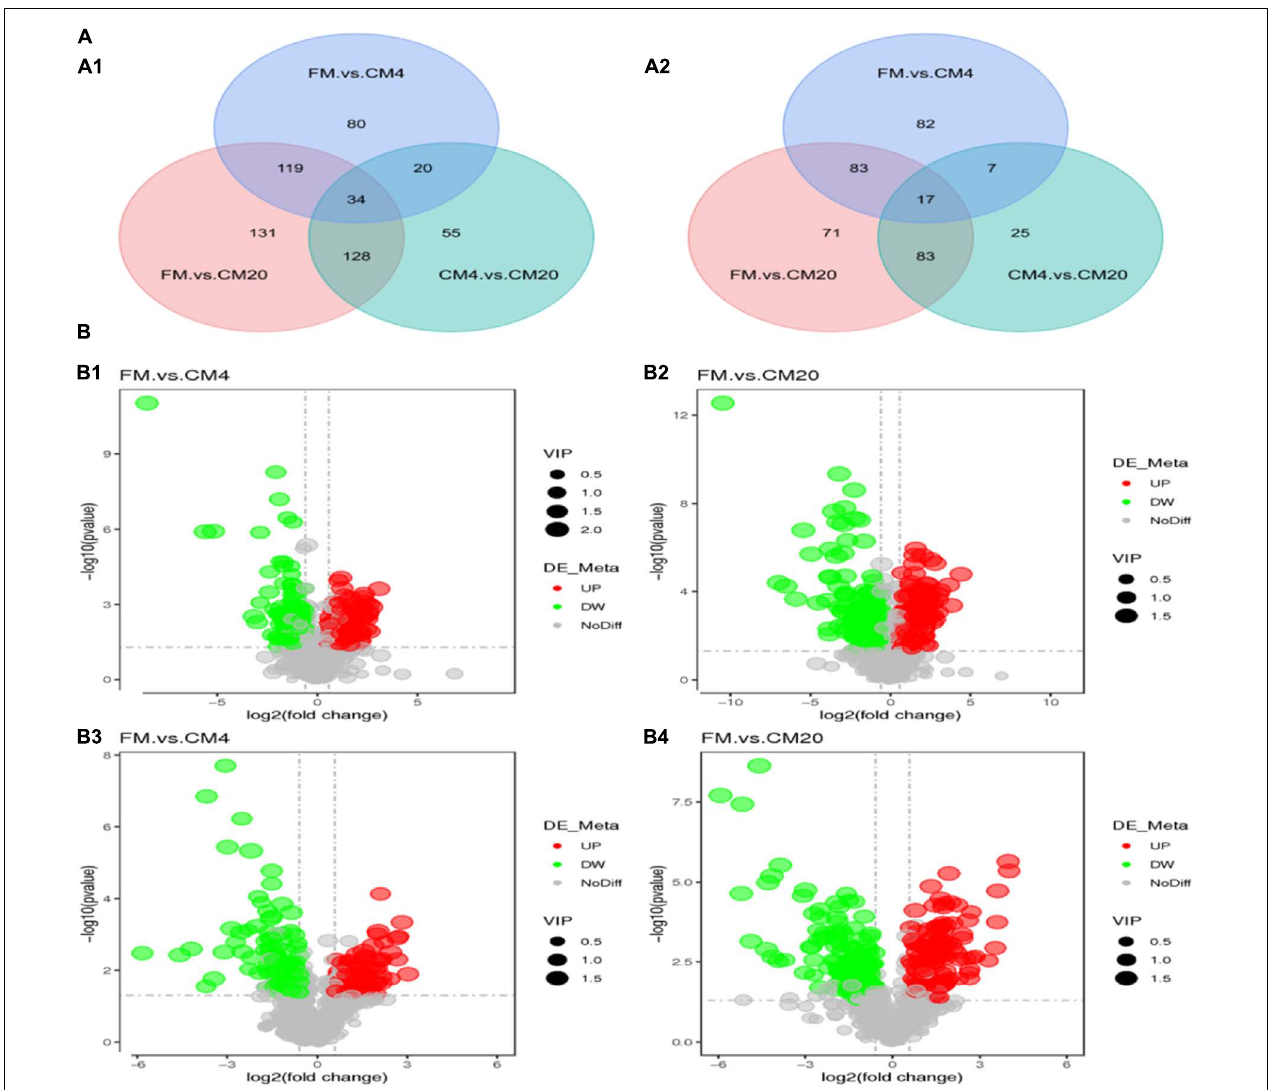
FIGURE 7 | (A) The Venn plot displays the differential metabolites of distal intestinal contents of hybrid grouper between experimental groups in positive (A1) and negative (A2) modes. (B) Volcano plots of p -values between the FM, CM4, and CM20 groups in the positive (B1,B2) and negative (B3,B4) modes. The horizontal coordinate represents the change of expression of multiple metabolites in different groups (log2FC), and the vertical coordinate represents the significance level of difference [–log10( p -value)]. Each dot in the figure represents a metabolite, and the size of the dot represents the VIP value. The significantly up-regulated metabolites are represented by red dots, the significantly down-regulated metabolites are represented by green dots, and gray dots represent no significantly different metabolites. Abbreviations are as defined in Figure 1 . n =